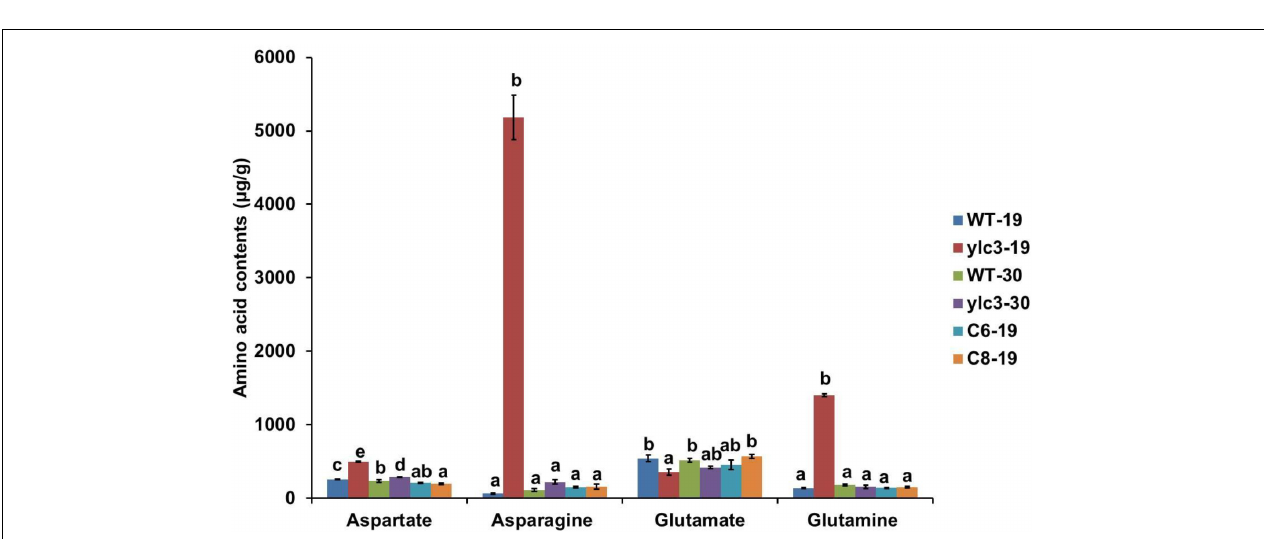
FIGURE 8 | Free amino acid analysis of 10-day-old WT and ylc3 seedlings grown at different temperatures. Error bars represent SD ( n = 3). Bars with different letters indicate significant differences at P < 0.05, ANOVA.